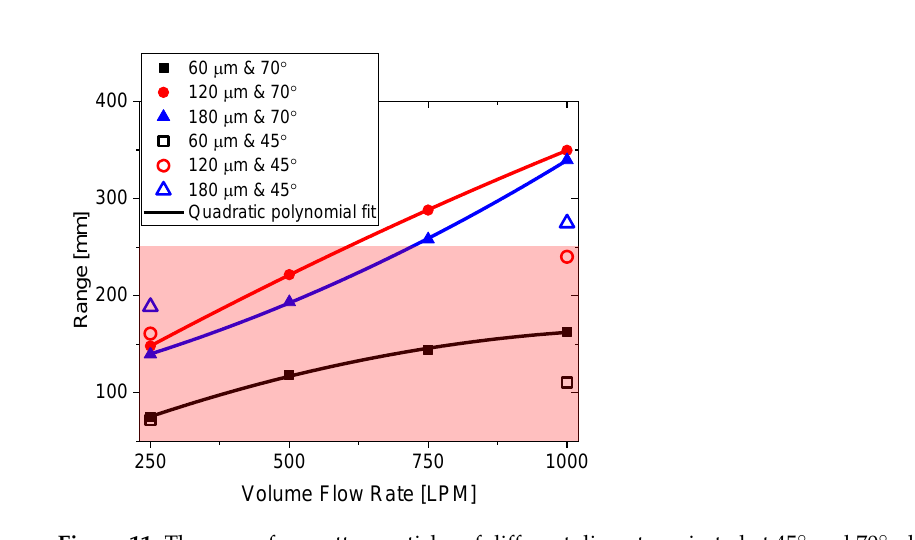
Figure 11. The range for spatter particles of different diameters ejected at 45° and 70° plotted against the inert gas volume flow rate for the base design .